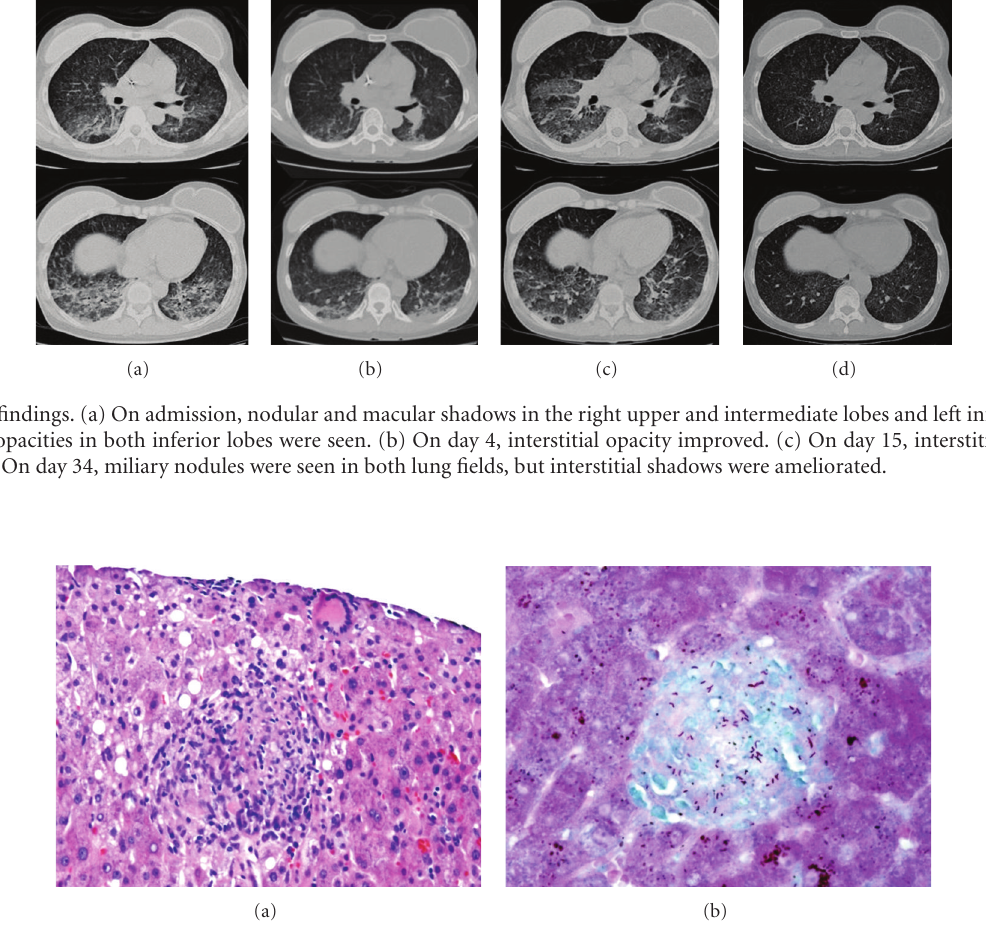
Figure 2: Pathological findings for the liver. (a) Hematoxylin and eosin (HE) staining showing Langhans’ giant cell and noncaseating granuloma ( × 400). (b) Positive results for Ziehl-Neelsen staining ( ×